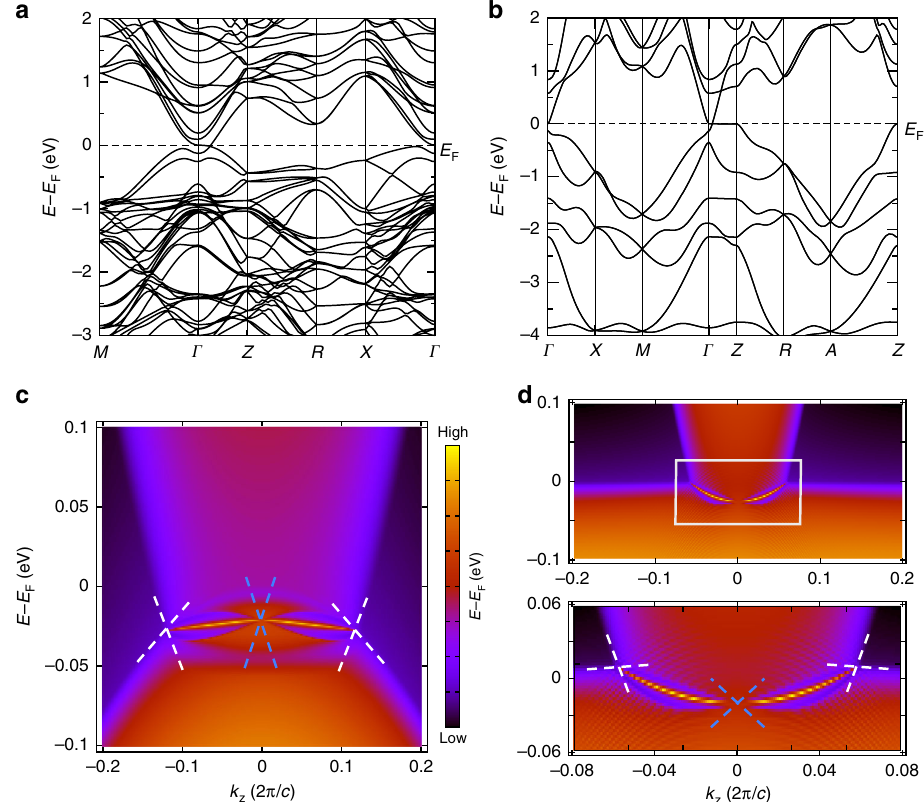
Fig. 4 HOFA states in α ″ -Cd 3 As 2 and KMgBi. a Bulk bands incorporating the effects of SOC of α ″ -Cd 3 As 2 in SG 137 ( P 4 2 = nmc 1 0 ) 10,18,20,56,57 . This semimetal exhibits T -reversed pairs of bulk 3D Dirac cones as well as 2D TI cones on its faces as a consequence of the nontrivial Z 2 topology of the k z = 0 plane (Supplementary Note 13) 10,18 – 20 . c The hinge spectrum of the k ⋅ p model of α ″ -Cd 3 As 2 introduced in ref. 18 exhibits previously undetected HOFA states connecting the projections of the bulk Dirac cones (white) to the hinge projection of the topological face cones (blue). b Bulk bands incorporating the effects of SOC and ( d ) hinge states of the candidate tilted Dirac semimetal KMgBi in SG 129 ( P 4 = nmm 1 0 ) 58,59 . d Zooming into the green boxed region, HOFAs are clearly visible connecting the projections of the bulk, tilted 3D Dirac points (white) to the projections of surface 2D TI cones (blue). The bulk band structures in ( a ) and ( b ) were obtained from fi rst-principles, and then used to fi t tight-binding models whose hinge Green's functions are shown in ( c ) and ( d ), respectively (Supplementary Note 13).